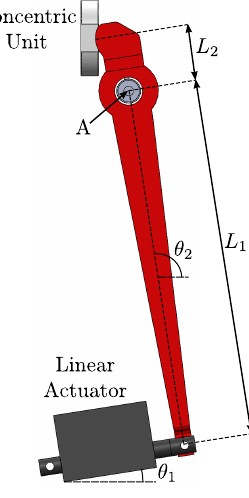
Figure 8: Radial load setup.